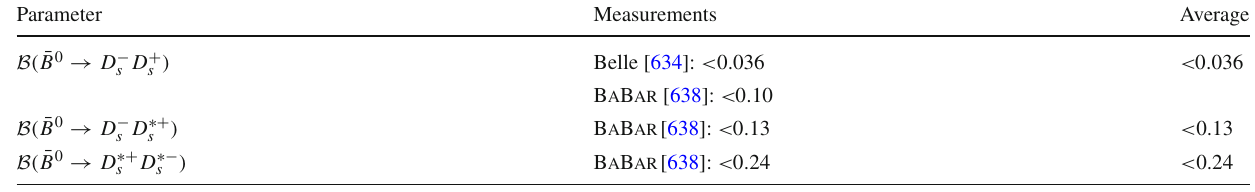
Table 111 Decays to D